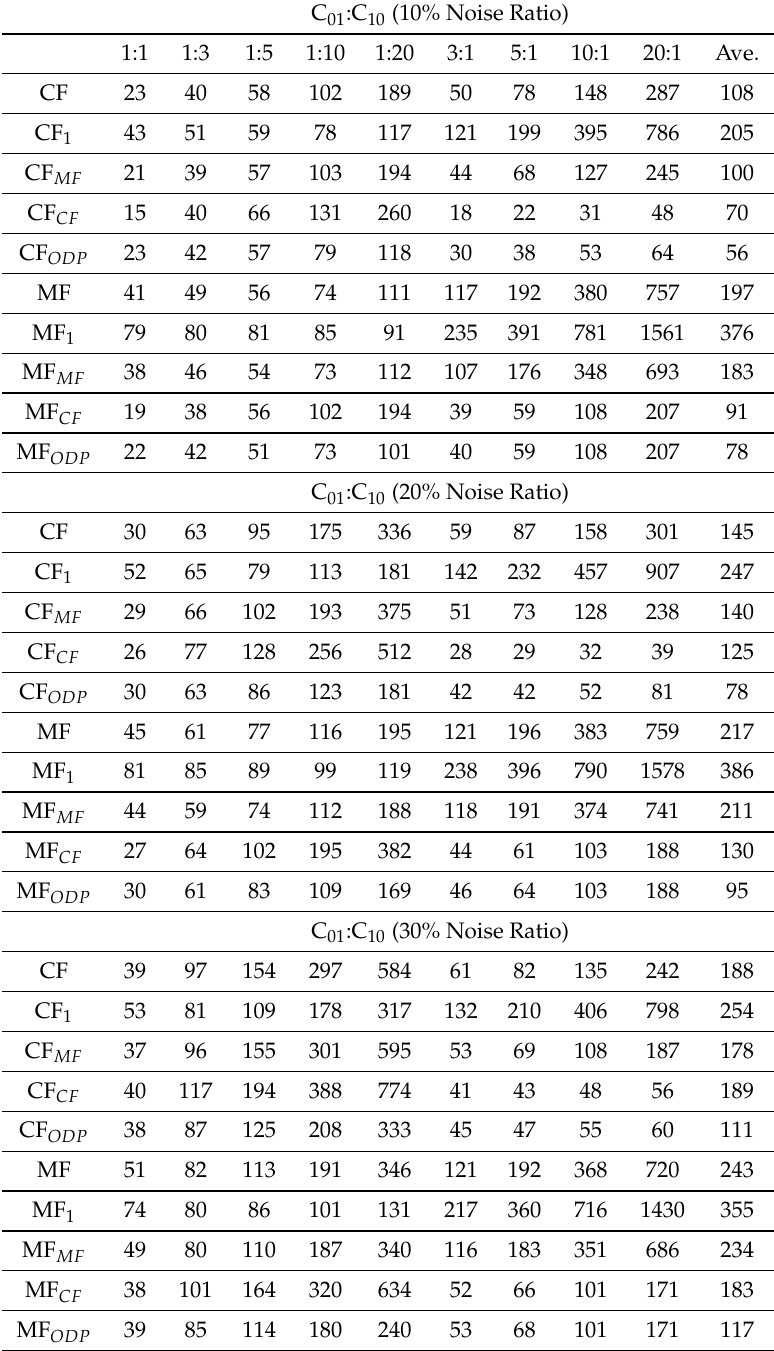
Table 11. Cost comparisons on Wpbc in the case that the noise ratio and noise-free dataset are